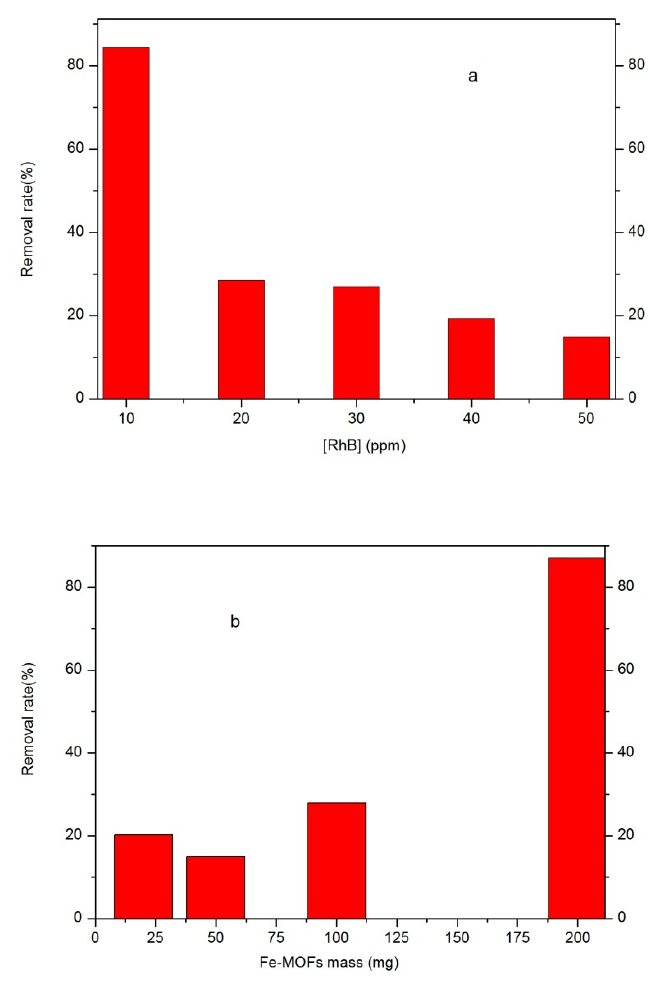
Figure 4. The removal rate of Fe-MOFs on RhB ( a ) 50 mg of Fe-MOFs ( b ) 50 ppm of RhB.